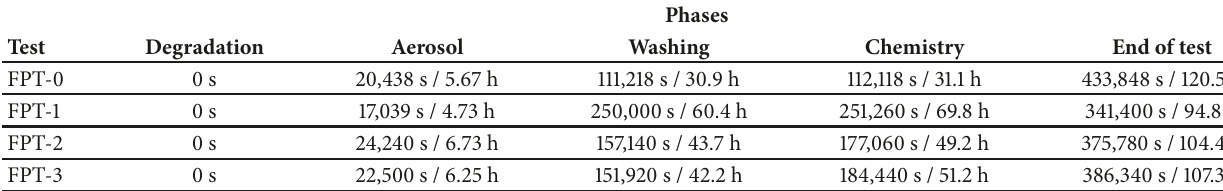
Table 2: Phase subdivision and timings of the Ph´ebus FPT tests.